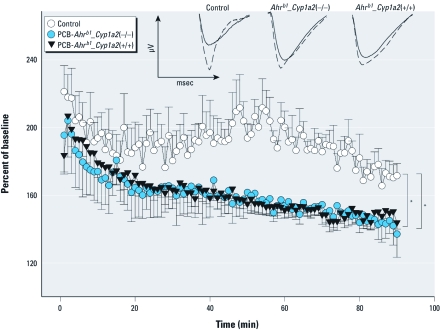
LTP results shown as the percentage of baseline (mean ± SE). The inset shows the EPSP slope in CA1 region slices; the solid line represents the baseline response, and the dashed line represents the response 30 min following tetanus [prolonged membrane response to the electrical stimulation; 100 Hz in 10 bursts (four pulses per burst) delivered at a burst frequency of 5 Hz for 2 sec]. No additional units are possible on the axes because the absolute amplitudes and times vary because of the different specific cells being measured (graphs in the inset represent the wave form, not the exact values of any given curve). No differences between the groups were seen within treatments for response to stimulus or baseline response (n = 6, with all mice originating from separate litters). ANOVA showed an effect of group (treatment/genotype) [F(2, 13) = 4.87; p < 0.05] and no group × time interaction. Dunnett tests comparing PCB-treated groups with controls showed that both the Ahrb1_Cyp1a2(+/+) and Ahrb1_Cyp1a2(–/–) PCB-treated groups exhibited significantly decreased LTP induction compared with untreated Ahrb1_Cyp1a2(+/+) controls. *p < 0.05 compared with control averaged across time.